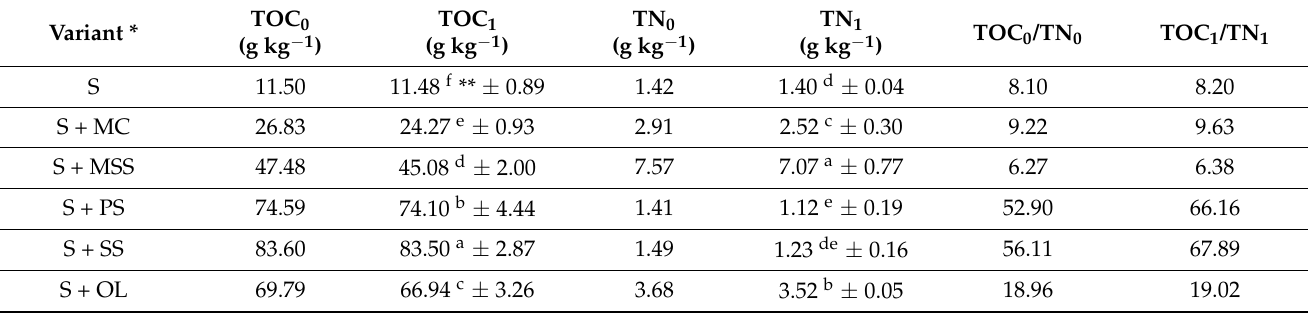
Table 2. Content of total organic carbon (TOC), total nitrogen (TN) and TOC/TN ratio in soil mixed with biochar before (0) and after 60 days of incubation